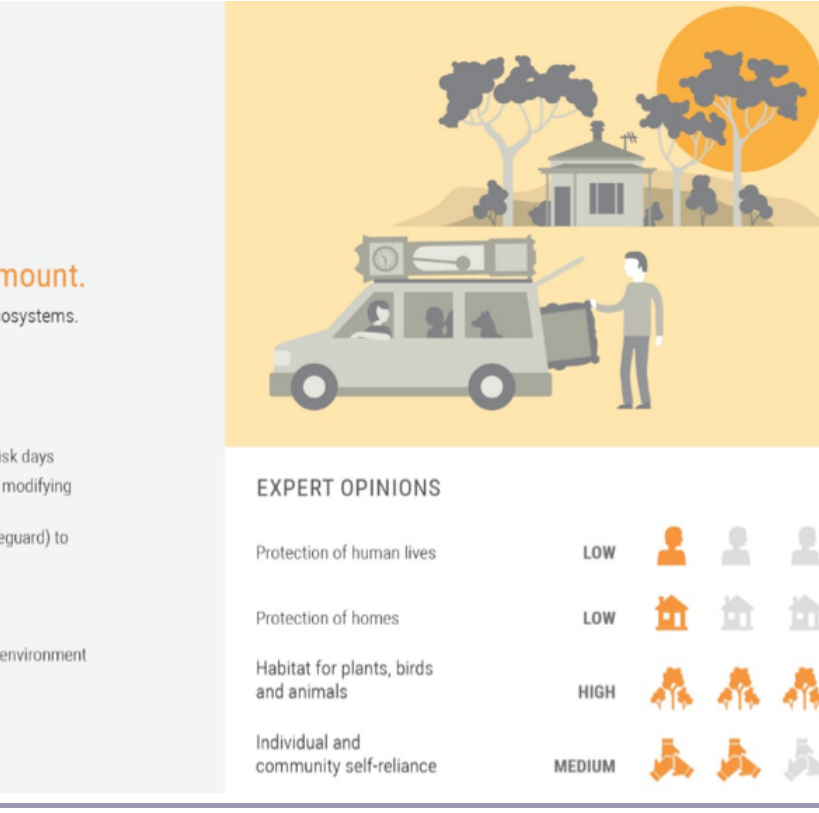
Fig. 8 . Illustration for “living with nature and bushfire,” one of the three scenarios refined from those developed in workshops that were shown to post-workshop interview